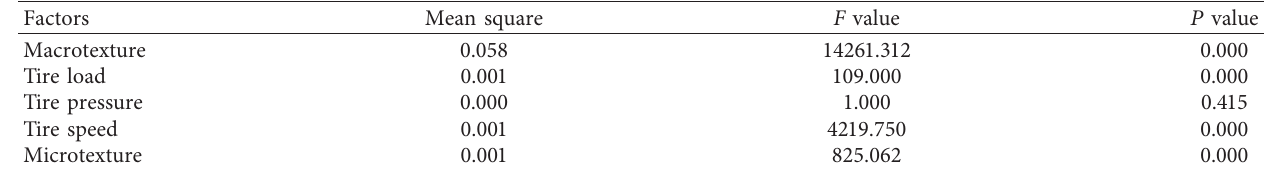
Table 7: ANOVA analysis of the orthogonal test.